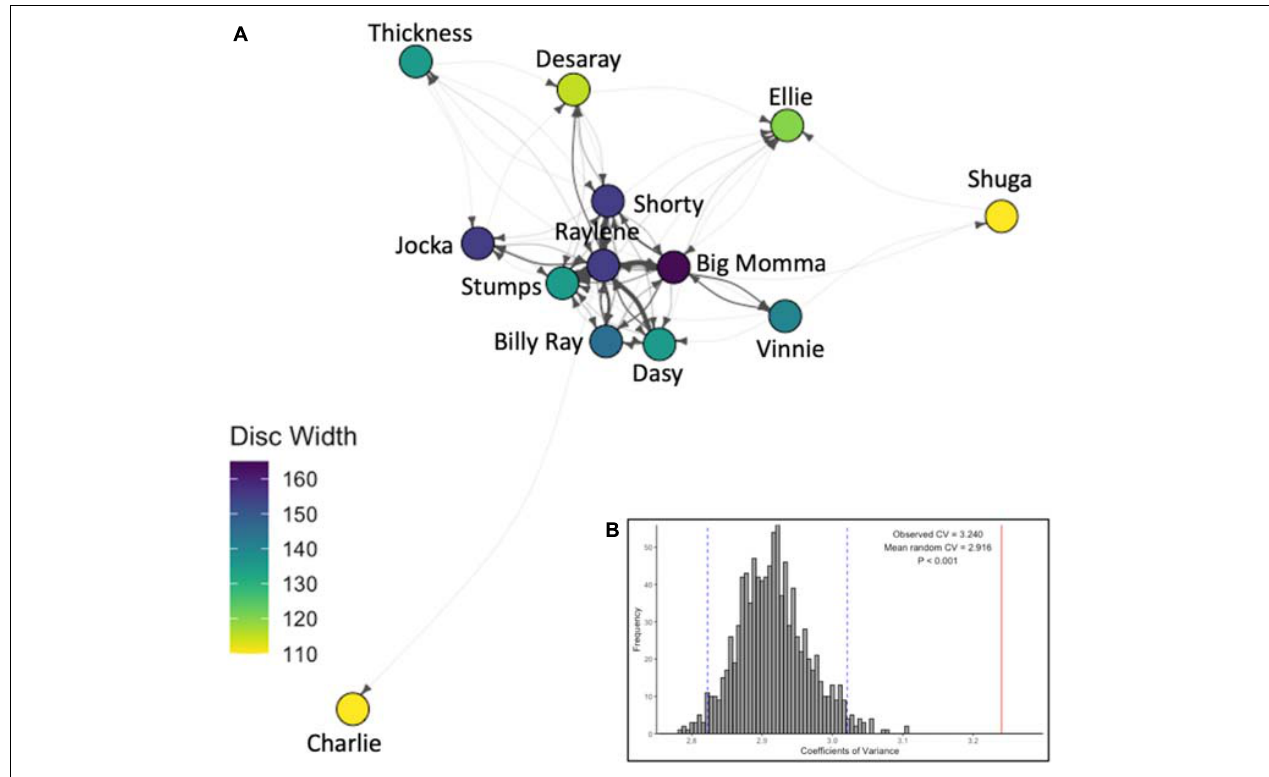
FIGURE 4 | The observed social network. (A) Weighted and directed social network, where arrows show direction of interactions, line thickness indicates total number of interactions between individuals in the given direction (divided by 10 for clarity), nodes are colored by disc width (cm). (B) Histogram of the Coefficients of Variation of 1,000 network permutations and 95% confidence intervals (vertical dashed blue lines) compared to that of the observed social network (vertical solid red